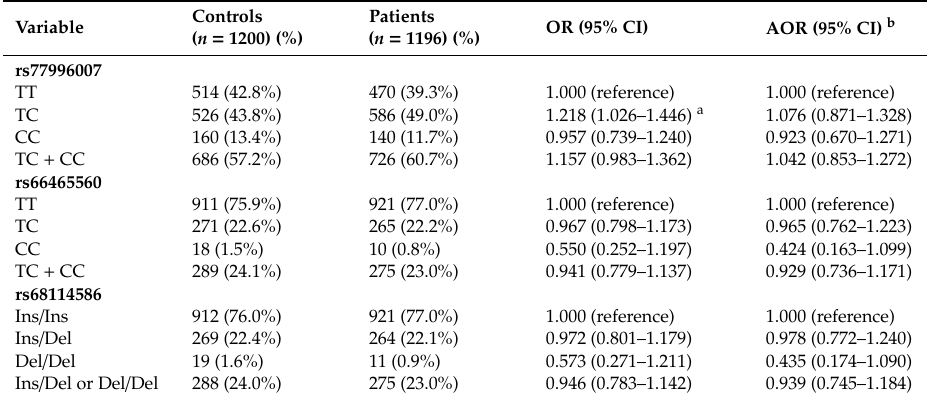
Table 2. The adjusted odds ratio (AOR) and 95% confidence interval (CI) of oral cancer associated with SOX11 genotypic